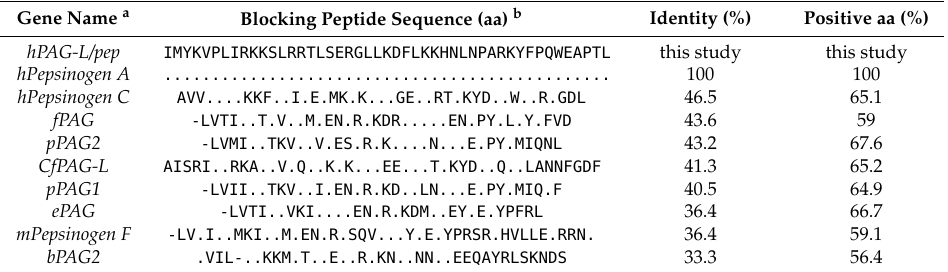
Table 2. Blocking peptide aa sequence homology of the human PAG-L/pep polypeptide precursor to various aspartic proteinases.